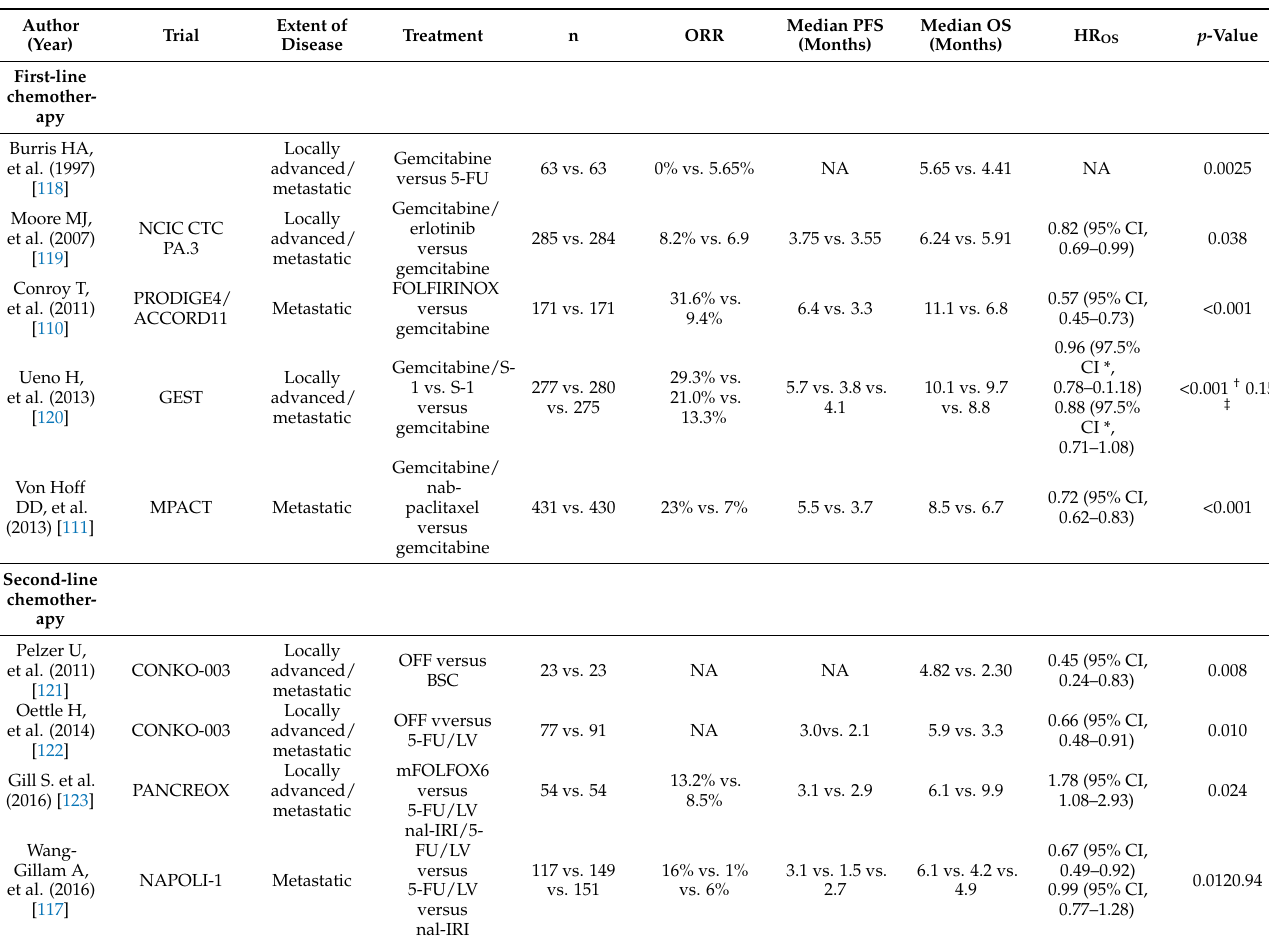
Table 2. Summary of pivotal trials of chemotherapy for pancreatic